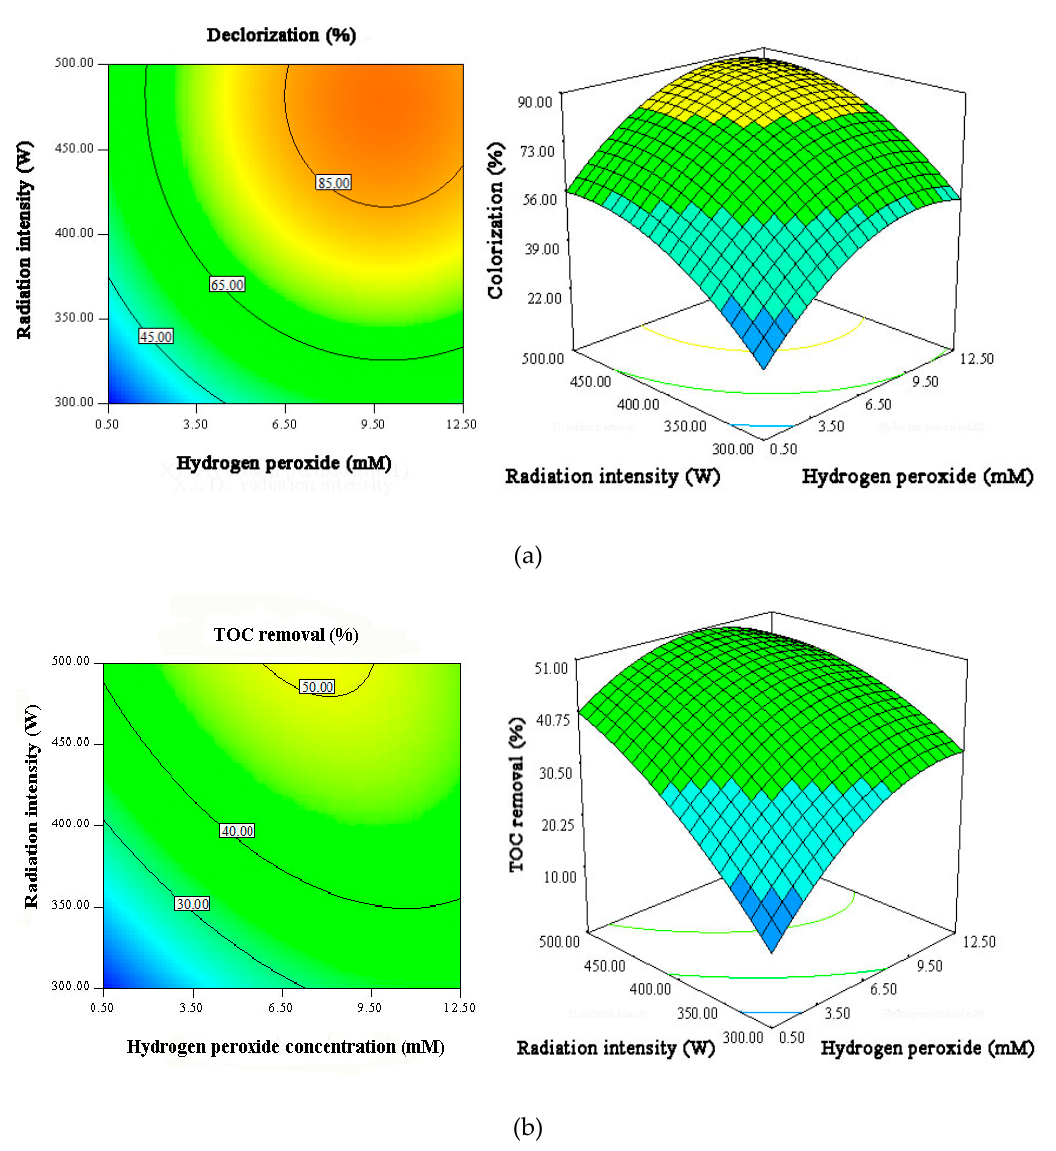
Figure 11. The contour plots and 3D surface responses for the effects of initial H 2 O 2 concentration and radiation intensity on MB decolorization efficiency ( a ) and TOC removal efficiency ( b ).